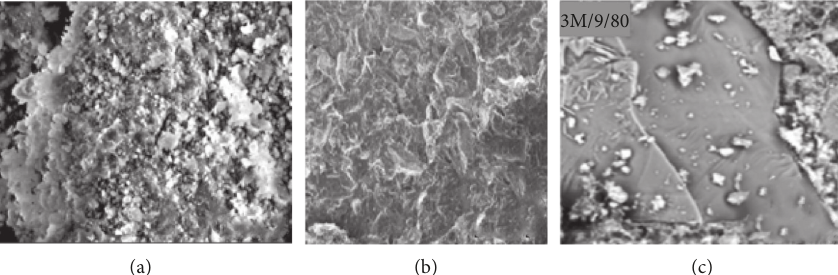
Figure 2: Representative SEM image of (a) Leached Palm Ash (b) Synthesized Zeolite Y IM/9 Hours (c) Synthesized Zeolite Y -3 M/9 Hours. All images were taken at a pressure of 70pa, accelerating voltage of 15kV, working distance of 10.8mm, lens magnitude of 15000x, and horizontal field width of 124 μ m.